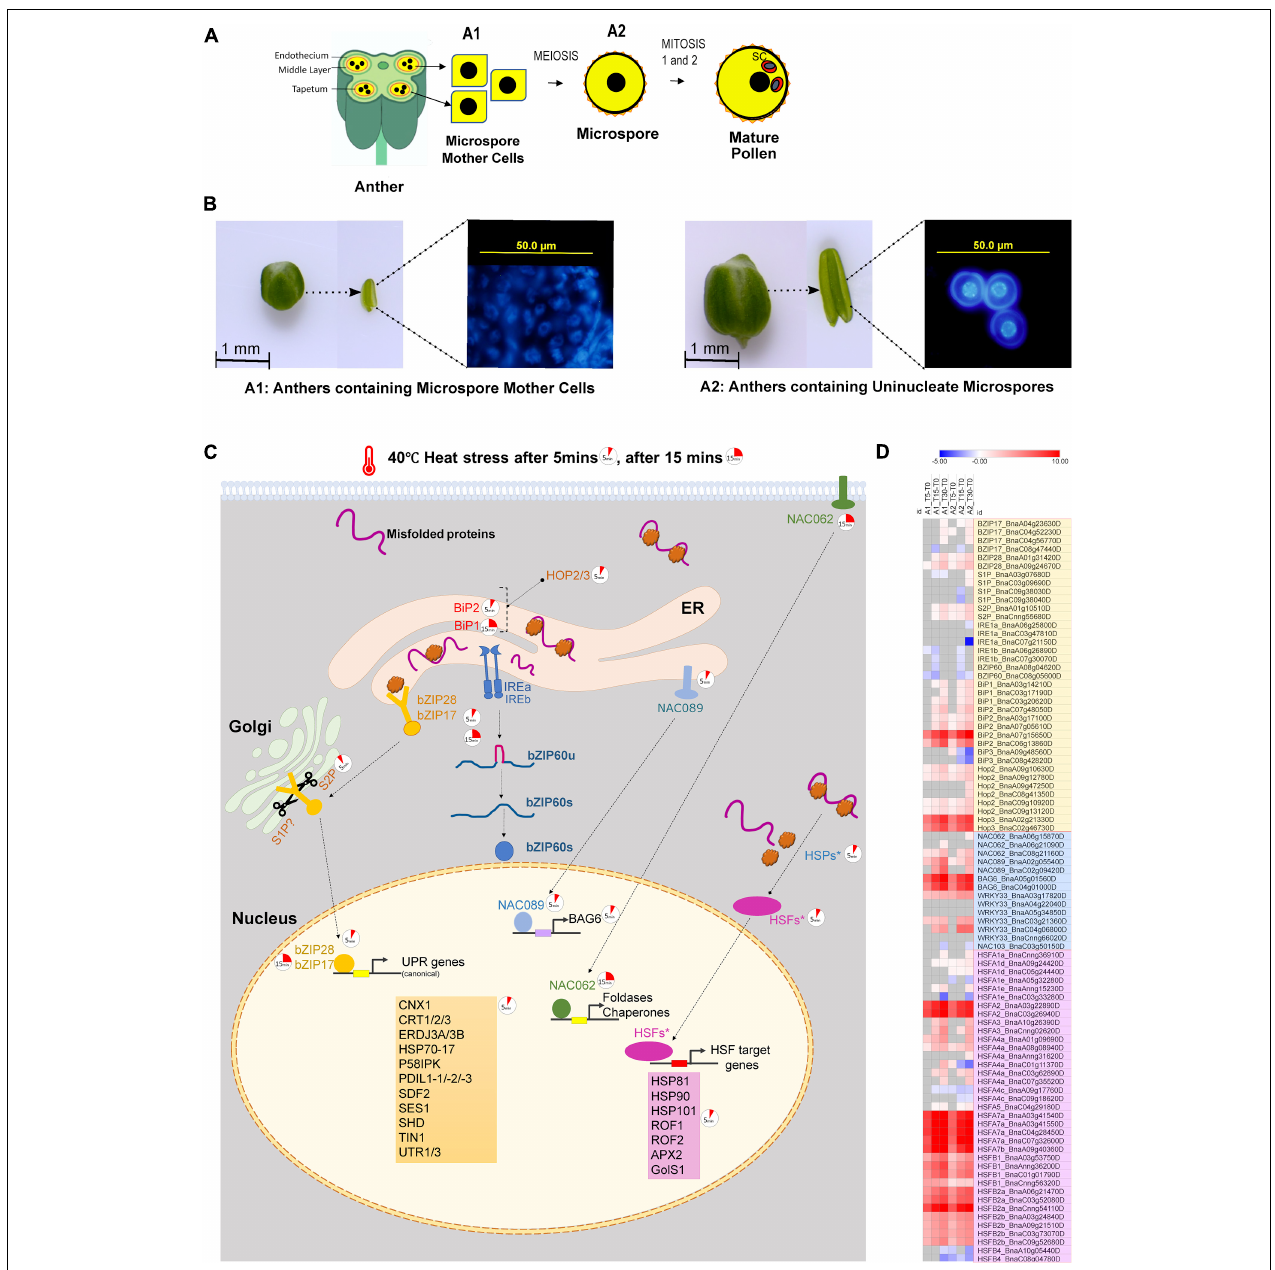
FIGURE 1 | (A) A diagrammatic representation of sectioned anther showing microspore mother cells (A1 anther stage), microspore (A2 anther stage) and mature pollen. (B) Brassica napus anther samples collected for RNA-sequencing. Anthers containing microspore mother cells (A1) and anthers containing uninucleate microspores (A2) were collected immediately after 5, 15, and 30 min of high-temperature exposure at 40 ◦ C. (C) Rapid transcriptional reprogramming of genes associated with unfolded protein response in the ER and cytoplasm within 5–30 min of heat stress exposure of the anthers (A1 and A2); the 5 min clock icon indicates the upregulation of gene after 5 min of heat stress, and the 15 min clock icon indicates the upregulation of gene after 15 min of heat stress. (D) Heatmap showing the Log 2 fold change in expression of transcripts associated with regulation of unfolded protein response in the ER and cytoplasm in anthers containing microspore mother cells and anthers containing uninucleate microspores subjected to heat stress for 5, 15, and 30 min; the transcripts in the light yellow box highlight the transcripts regulating the two arms of the unfolded protein response in ER, i.e., the bZIP28/17 dependent pathway and the bZIP60-IREa/b dependent pathway; the transcripts in the light blue box are ER-UPR associated NAC TFs and their selected targets; and the transcripts in the light magenta box are heat shock transcription factors ( HSFs ) which are associated with the regulation of unfolded protein response in the cytoplasm.